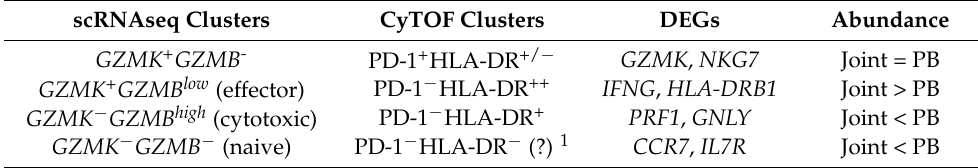
Table 3. CD8 T-cell clusters in RA joints reported by Zhang et al. [33] and Jonsson et al. [52]. scRNAseq Clusters CyTOF Clusters DEGs